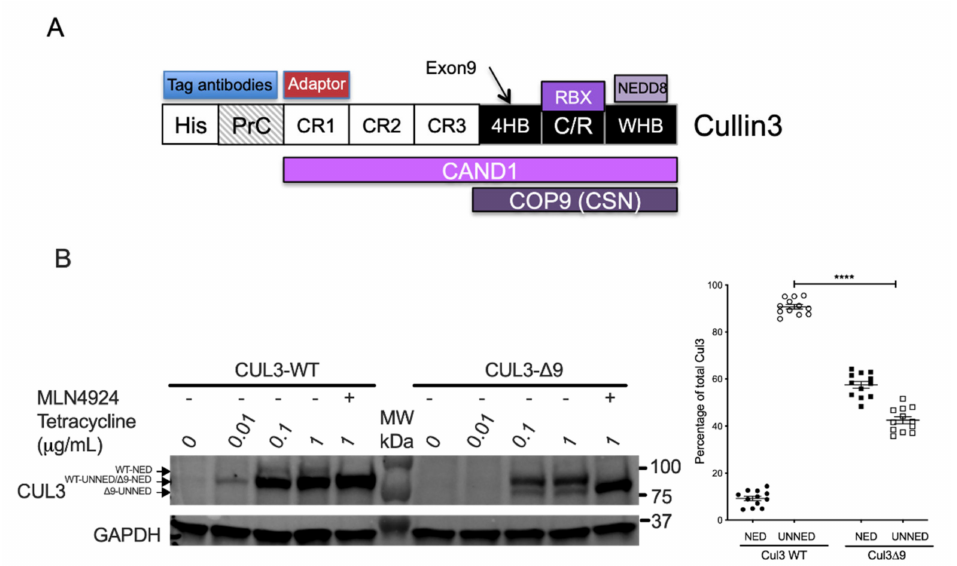
Figure 1. General structure of CUL3 and production of cell lines expressing CUL3-WT and CUL3- ∆ 9. ( A ). CUL3 protein comprises several domains including (from the N- to the C-terminus): three tandem cullin-repeat domains (CR1-CR3), a four-helix-bundle domain (4HR), which includes exon 9-coded sequence, followed by a cullin/ring intermolecular domain (C/R), which intertwines the cullin 3 and RBX proteins, and finally the winged-helix B (WHB) C-terminal domain, which contains the neddylated lysine 712. For the expression in 293 cells, two short tags (6xHis and protein C tags) were added at the N-terminus in order to be recognized by specific antibodies. The different proteins interacting with CUL3 are indicated as aligned with their corresponding CUL3-interacting domain(s). ( B ). The cDNA sequence of CUL3-WT or CUL3- ∆ 9 was inserted in the pcDNA5/FRT/TO/(His)6- Protein C vector and therefore tagged at its N-terminus with the Protein C peptide (PrC) and the 6xHis tags. These constructs were stably transfected in Flp-In TM T-REx TM 293 cells (Invitrogen). The expression of PrC-CUL3-WT and PrC-CUL3- ∆ 9, induced by 0.01 to 1 µ g/mL tetracycline or not, was assessed by Western blot using the polyclonal HPC4 antibody (Cell signaling) as primary antibody. Neddylated (NED) and unneddylated (UNNED) forms of CUL3-WT and CUL3- ∆ 9 were quantified on several blots ( n = 13) and the ratio of each form was plotted as a percentage of total expression. The percentage of neddylated (11.6 ± 2.5%) versus unneddylated (88.4 ± 2.5%) form of CUL3-WT was significantly different (**** = p < 0.0001) from that of CUL3- ∆ 9 (59 ± 2% and 41 ± 2%, respectively) ( t